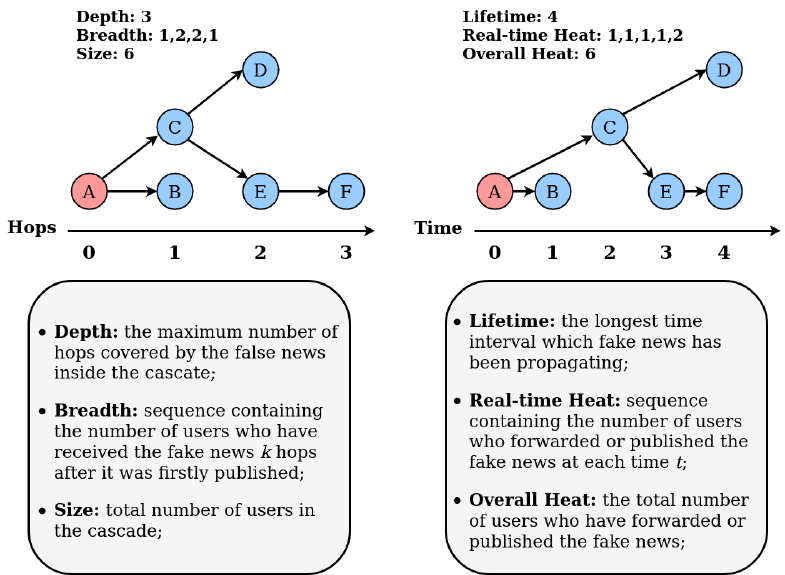
Figure 1. Cascades of fake news in a hop-based ( left ) and time-based ( right ) perspective. The root node A , in both perspectives, represents the first user to publish or create the fake news, while the remaining nodes represent users that actively forward or share the fake content. Adapted from